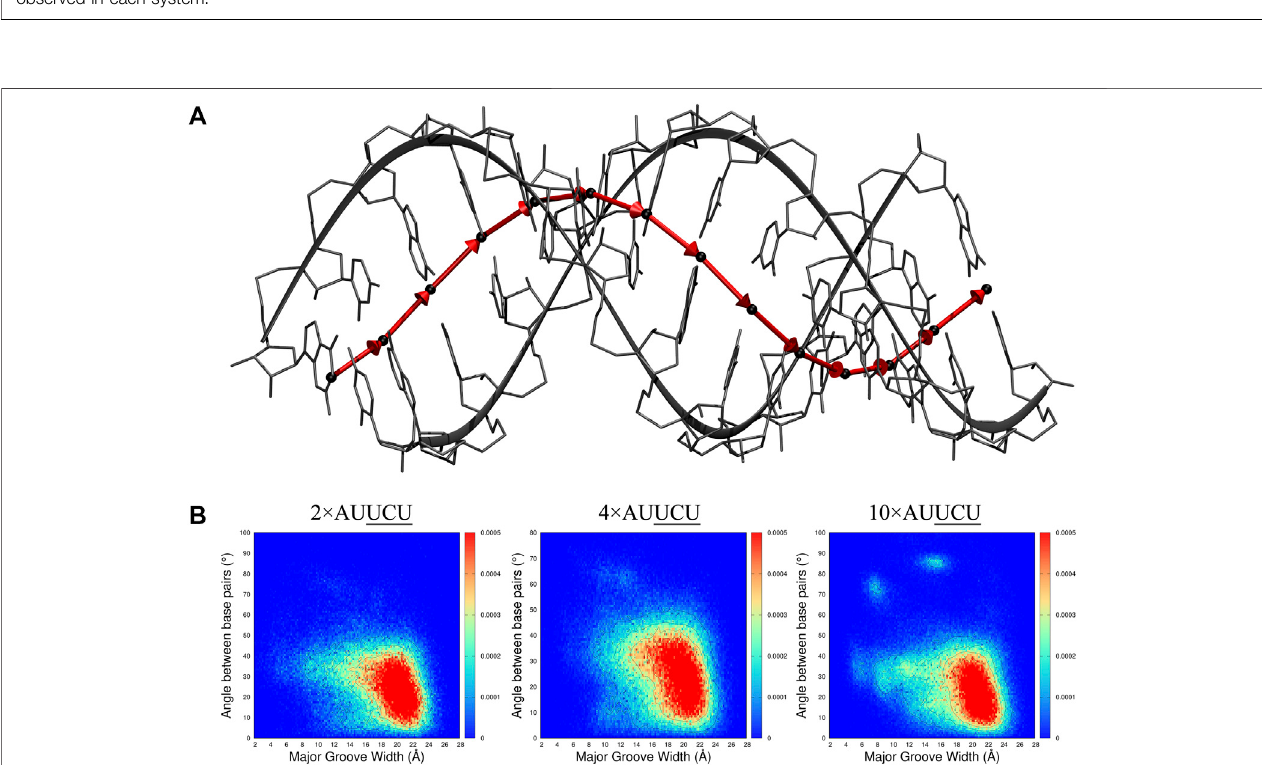
FIGURE9| 2Ddistributionanalysesofmajorgroove width (Mgw)and areactioncoordinate (B) representingangular change( θ )ofbasepairstep orientation (A) . In themodelsystemdisplayedinA,centerofmass(COM)ofeachbasepairisrepresentedwithblackspheres,andvectorsconnectingtheCOMsofconsecutivebasepairs are displayed with red arrows. The angular change of the vectors is used as a reaction coordinate to investigate bending observed in RNA repeat expansions. In B, 2D (Mgw, θ )distributionanalysesof2×AUUCU,4×AUUCU,and10×AUUCUareshown.Notethatastherepeatsizeincreases,unique(Mgw, θ )regionsareobservedin the plots such as (Mgw = 7 Å, θ = 70 ° ) and (Mgw = 16 Å, θ = 90 °